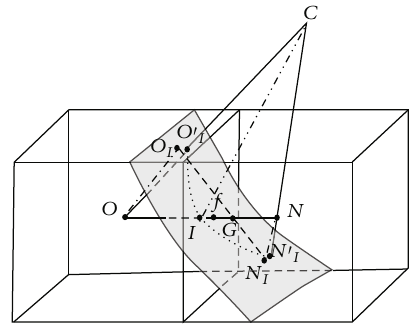
Figure 3: Illustration of approximation of phase interface using